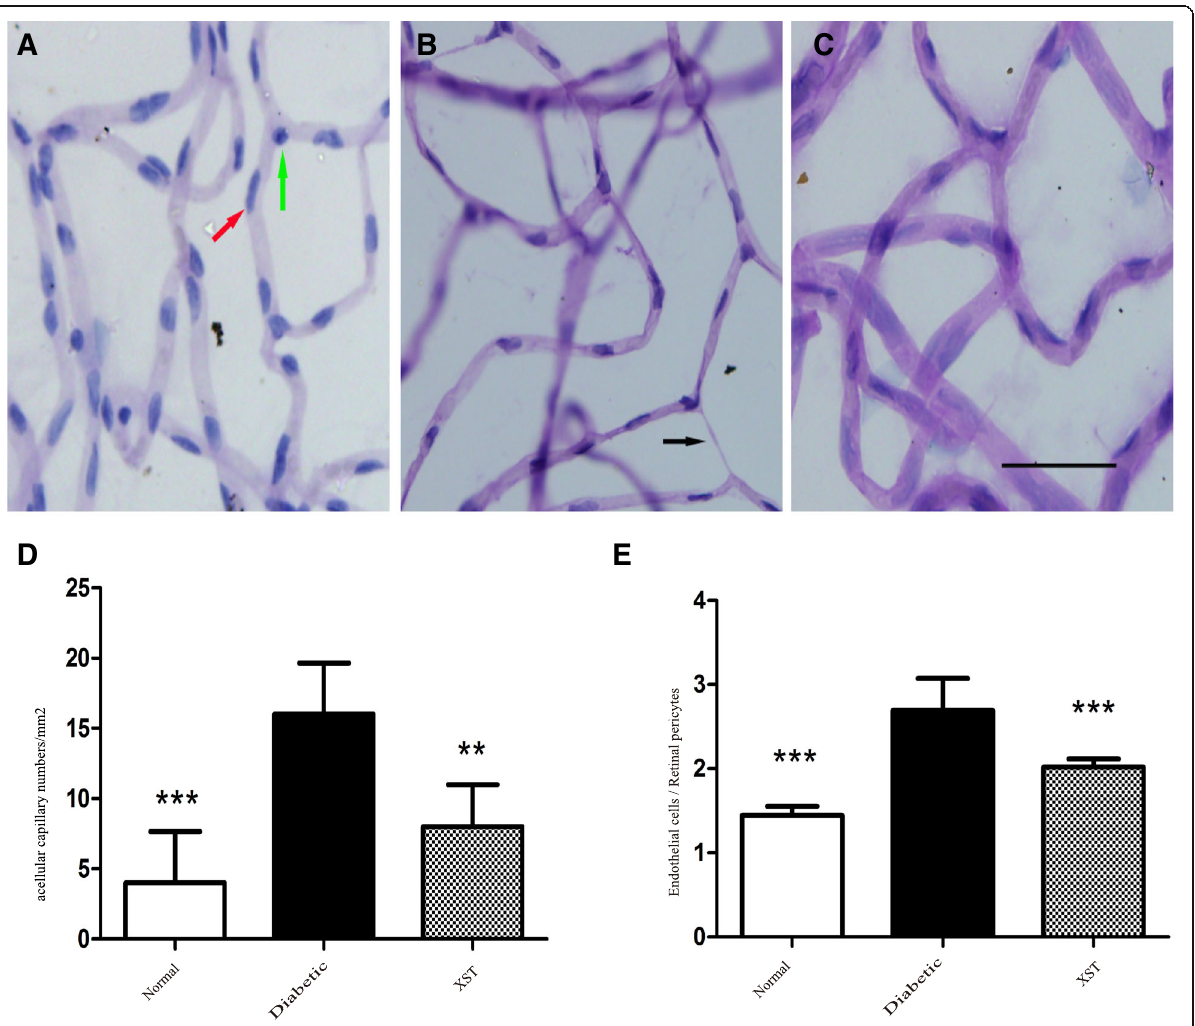
Fig. 3 The effect of XST on morphology of rat retinas. The retinas were fixed in formalin for trypsin digestion. a – c The vasculature in midretina. Scale bar: 50 μ m. The images showed the acellular capillaries ( black arrow ), endothelial cells ( green arrows ) and pericytes( red arrow ). d The acellular capillaries were counted and expressed as the total number/mm of retina area. There was a remarkable decrease in cellular capillaries in XST group. e The endothelial cells and pericytes were identified and counted. Then the ratio of endothelial cells number /pericytes number was calculated. XST administration improved the ratio of endothelial cells number /pericytes number. Data were represented as mean ± S.D. ( n = 3 – 5).*: P < 0.05, **: P < 0.01, ***: P < 0.001, compared to